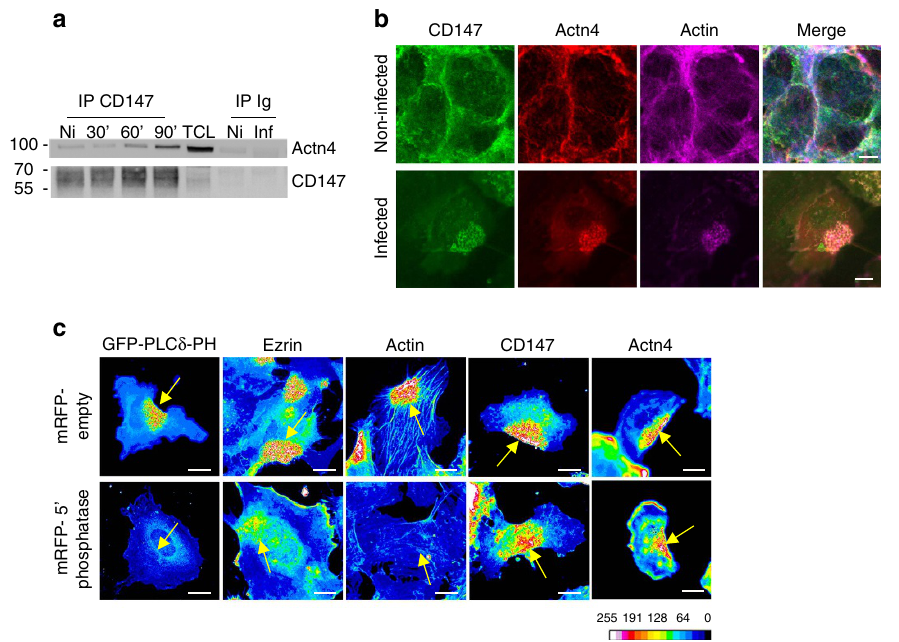
Figure 4 | a -Actn4 is recruited to bacterial adhesion sites together with CD147. ( a ) Actn4 co-immunoprecipitates with CD147. HBMECs were either non-infected (Ni) or infected with meningococci for the indicated period of time before lysis. CD147 was immunoprecipitated (irrelevant antibody (Ig) as control) and the obtained samples were successively immunoblotted with anti-Actn4 (top) and anti-CD147 antibodies (bottom). The total cell lysate (TCL) was loaded as a control. ( b ) CD147 and Actn4 colocalize at endothelial cell junctions and at sites of bacterial adhesion. HBMECs non-infected (top) or infected for 2h with meningococci (bottom) were stained for CD147 (green), Actn4 (red) and actin (blue) and analysed by confocal microscopy. Merged images of the same fields are presented on the right (scale bar, 10 m m). ( c ) Actn4 accumulates at sites of bacterial adhesion independently of PI(4,5)P 2 production and cortical actin polymerization. HBMECs were transfected with GFP-tagged PH domain of PLC- d 1, along with the membrane- targeted FRB-CFP and the mRFP-FKBP domain constructs (with or without 5 0 -phosphatase domain as indicated), infected with meningococci for 2h in the presence of rapamycin to induce the translocation of 5 0 -phosphatase to the plasma membrane and stained for ezrin, actin, CD147 and Actn4. The colour bar indicates the pixel intensity of normalized fluorescence images (in arbitrary units). Arrows point at sites of bacterial adhesion. Control GFP, mRFP-FKBP, mRFP-FKBP-5-phosphatase and FRB-CFP fluorescence images are shown in Supplementary Fig. 5. Images are representative of five independent experiments (scale bars, 10 m